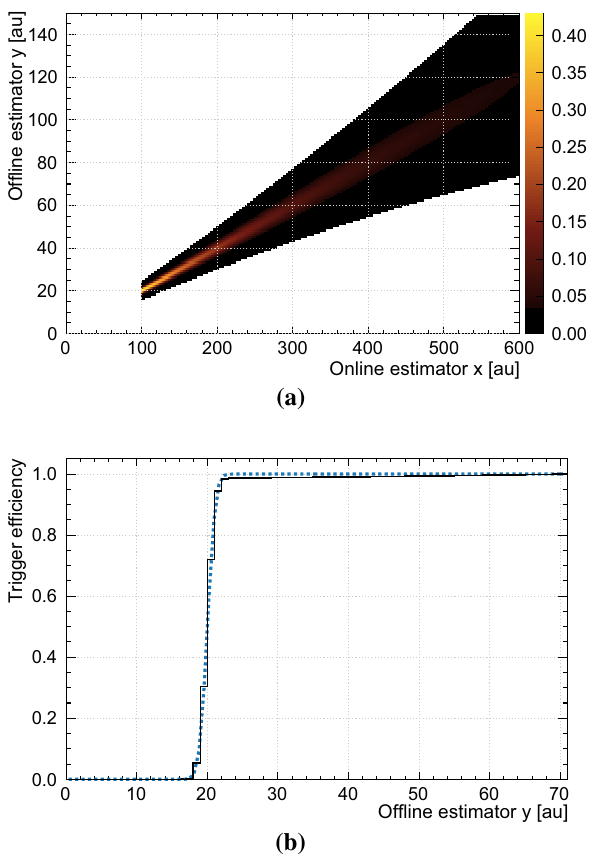
Fig. 6 The Gaussian example with μ = 0 . 2 y + 5 · 10 − 5 y 2 and σ = 0 . 015 y . No plateau arises, hence the method is not applicable and b does not represent the trigger